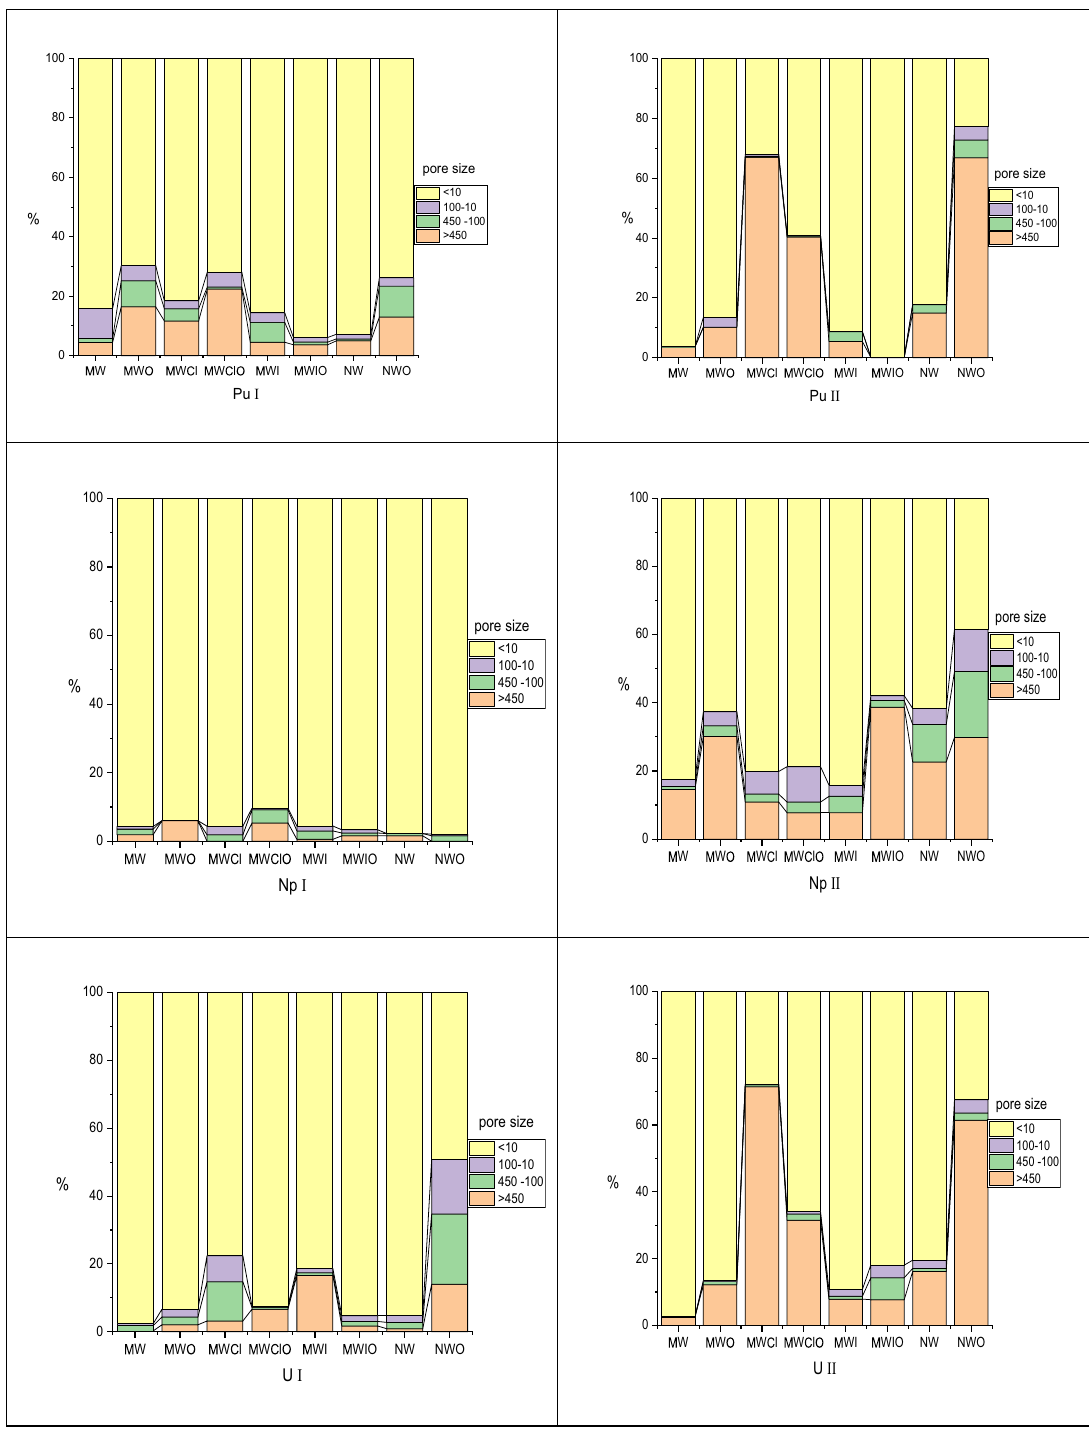
Figure 4. Actinide distribution by size of colloidal particles in solutions of different nature depending on the incubation time, normalized % in the filtrate. (I-before, II-after microbial stimulation on day 30). Actinides (233U, 237Np, and 239Pu) were added in the concentrations of 10 –8 M/l per sample. Concentrations of 233 U 239 Pu were determined by liquid scintillation (Tri-Carb-3180 TR/SL liquid scintillation spectrometer) ("Perkin- Elmer,"